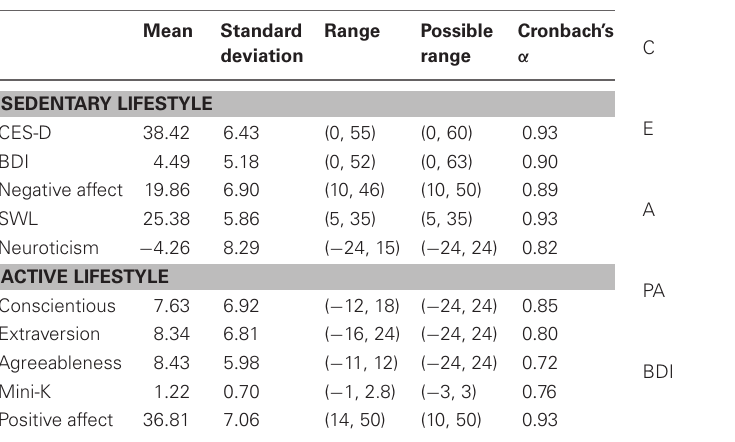
active lifestyle factors.